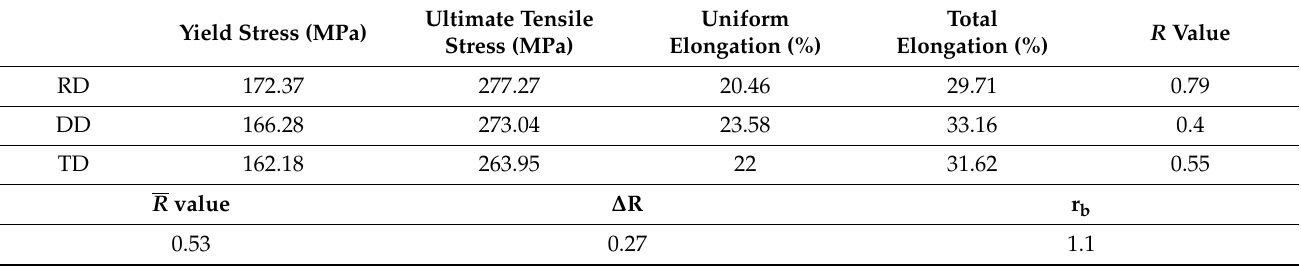
Table 3. Mechanical properties of AA6022-T4 (RD, DD, and TD are rolling, diagonal, and transvers direction, respectively).